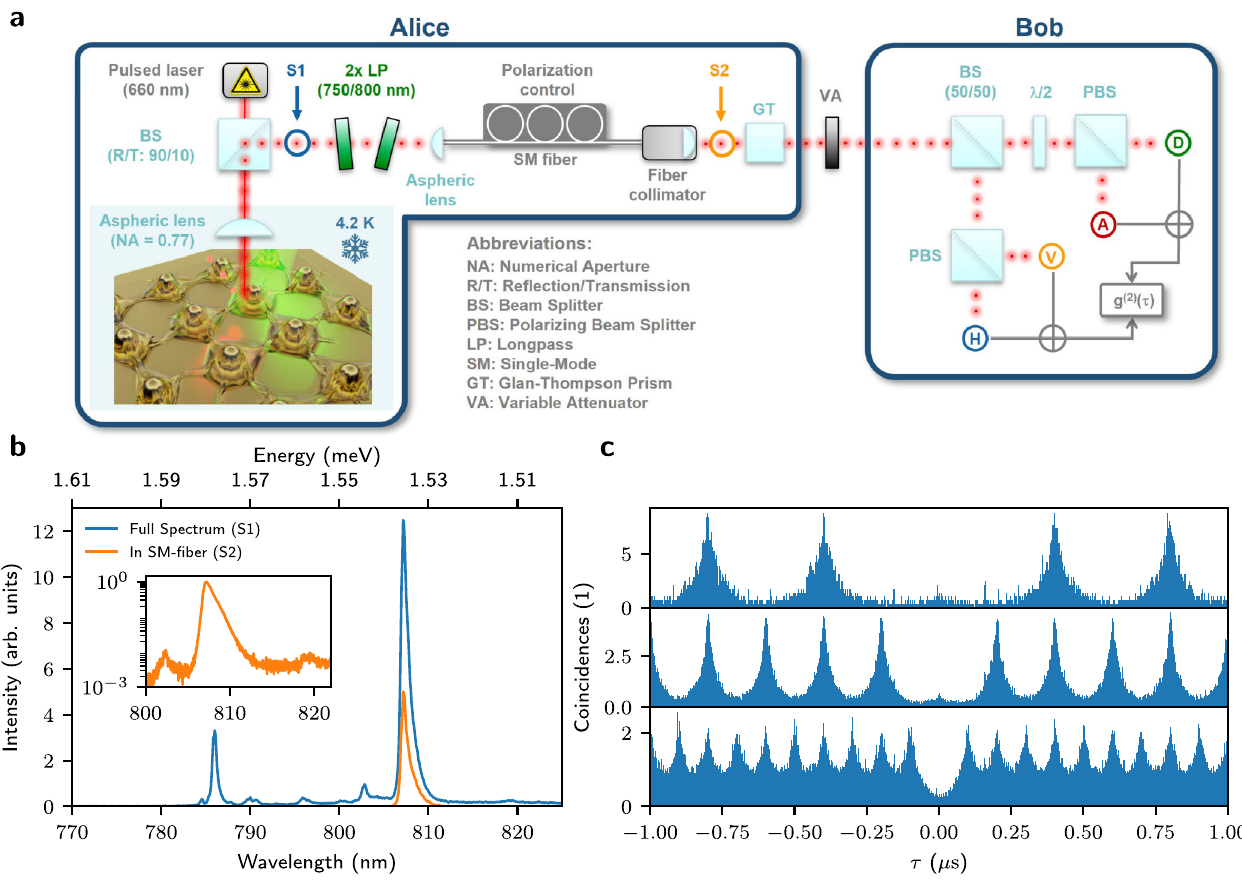
Fig. 1 BB84-QKD setup employing an atomically thin single-photon source. a The transmitter (Alice) comprises a strain-engineered WSe 2 monolayer inside a closed-cycle cryocooler, a diode laser with variable repetition rate, dielectric fi lters, and an optical fi ber together with a polarizer for adjusting the polarization states. Alice sends single-photon pulses with fi xed polarization (H, V, D, A) to the receiver (Bob). Inside the quantum channel, losses can be introduced using a variable attenuator. Bob comprises a four-state polarization analyzer based on bulk polarization optics. b Emission spectra of the WSe 2 monolayer sample recorded at different locations in the setup: before (blue) and after (orange) spectral fi ltering and coupling to the SM fi ber. The selected quantum emitter emits at a wavelength of 807 nm. c Second-order autocorrelation histograms of the triggered quantum emitter at clock rates of 2.5, 5.0, and 10.0 MHz. The autocorrelation is evaluated from the events registered at all four receiver